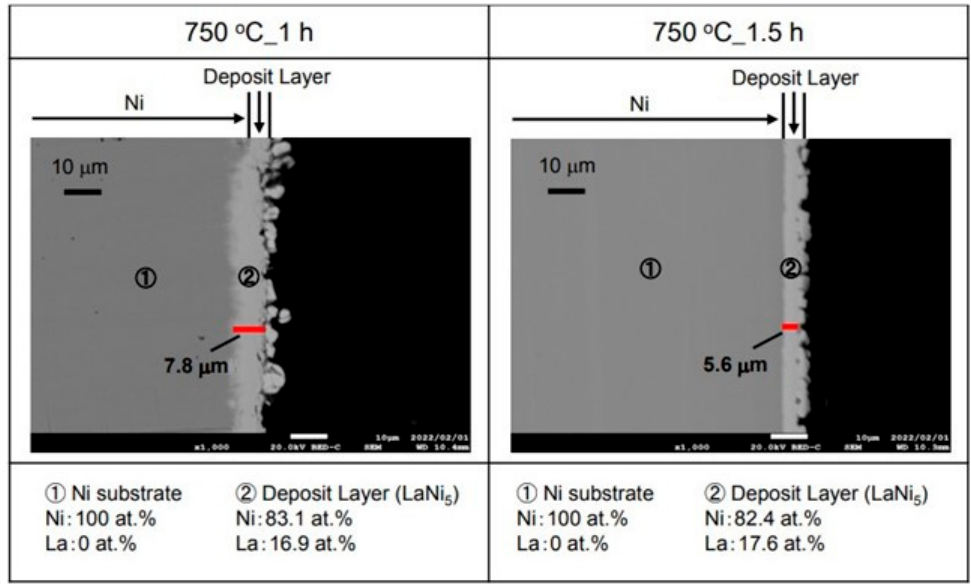
Figure 4. Cross-sectional microstructure and element analysis of Ni after La deposition at − 2.25 V in NaCl-KCl-5.0 mol%LaF 3 melts at 750 °C.